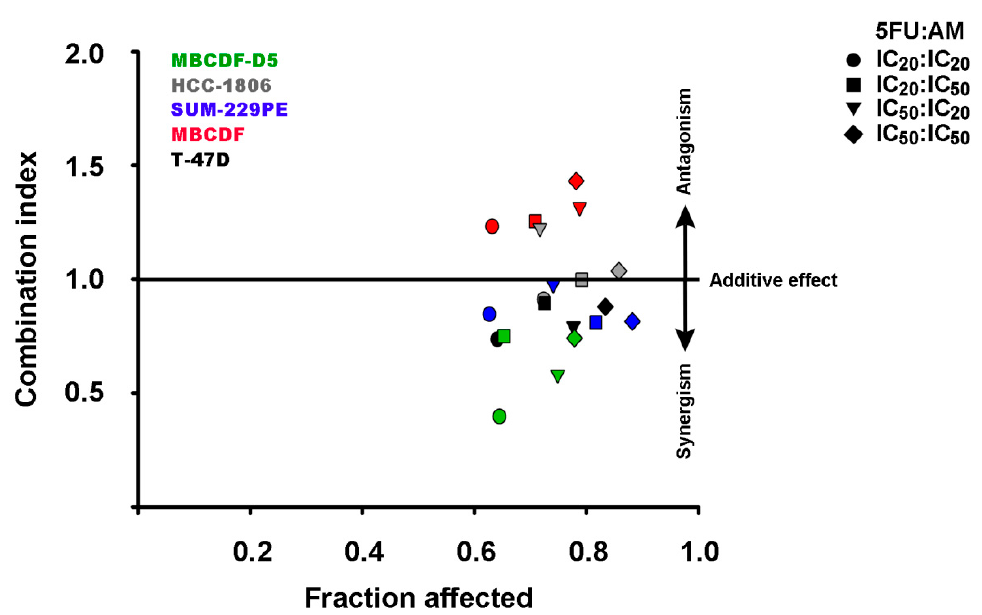
Figure 3. Combination index versus fraction affected in cells exposed to different combinations of 5-fluorouracil with α -mangostin. The combination index and the fraction affected were determined by co-incubating the cells in the presence of the inhibitory concentrations at 20% (IC 20 ) and/or 50% (IC 50 ) of 5-fluorouracil (5-FU) and α -mangostin (AM) in the breast cancer cell lines MBCDF-D5, HCC-1806, SUM-229PE, MBCDF and T-47D. The combination schemes evaluated (5-FU/AM) were IC 20 /IC 20 , IC 20 /IC 50 , IC 50 /IC 20 and IC 50 /IC 50 . The symbols under, on or over the horizontal line depict synergism, addition or antagonism, respectively. Fraction affected values closer to 1 indicate greater inhibitory growth effect than values closer to 0. N ≥ 3 independent experiments with six replicates each. Table 3. Dose reduction index of 5-fluorouracil and α